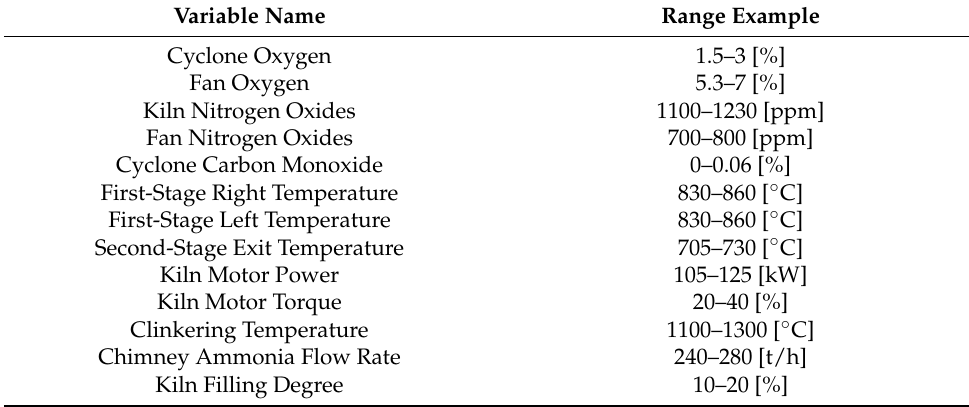
Table 3. Rotary kiln APC system: main